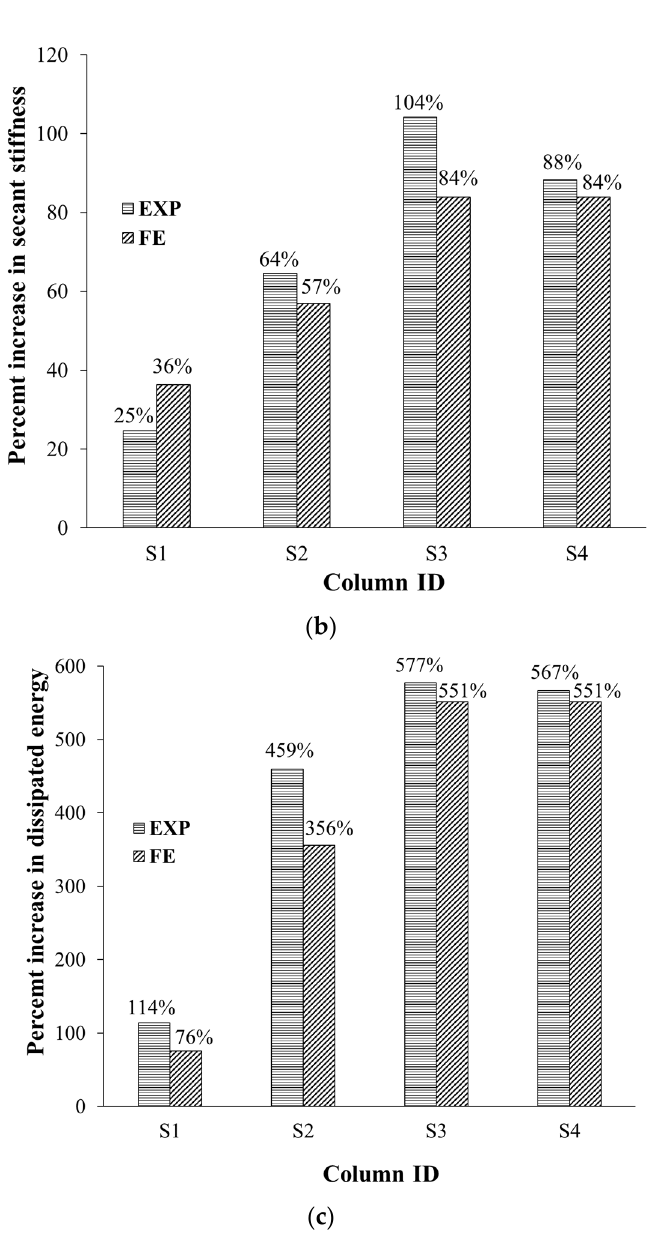
Figure 20. Comparison of upgraded columns with regard to the percent increase in ( a ) peak load, ( b ) axial sti ff ness, and ( c ) energy dissipated.